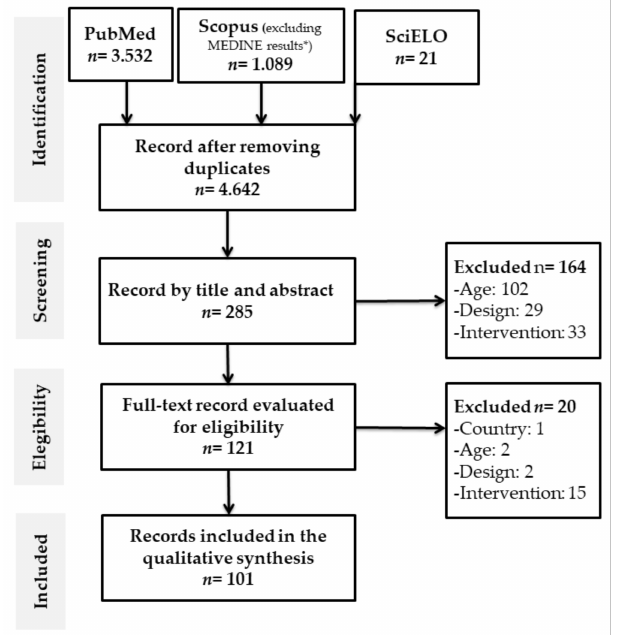
Figure 1. Literature search Flow chart. * Whole search strings for all databases are presented in the supplementary material (Table